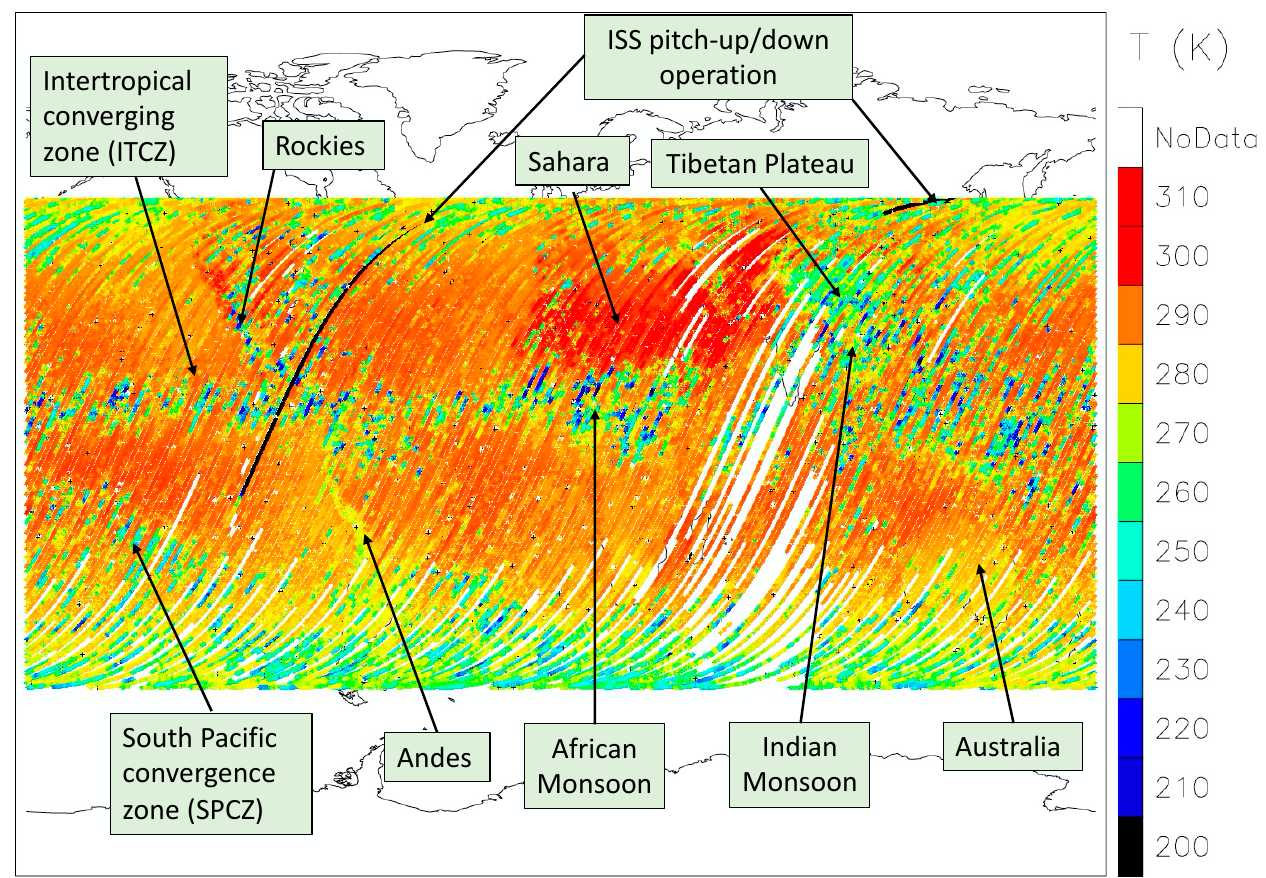
Figure 12. Global nighttime brightness temperature of CTI band1 (MWIR) from the ascending orbits in July 2019. Only center-pixel data are shown on the map for better illustration. White orbital gaps represent regions wherein no data were acquired in this period.